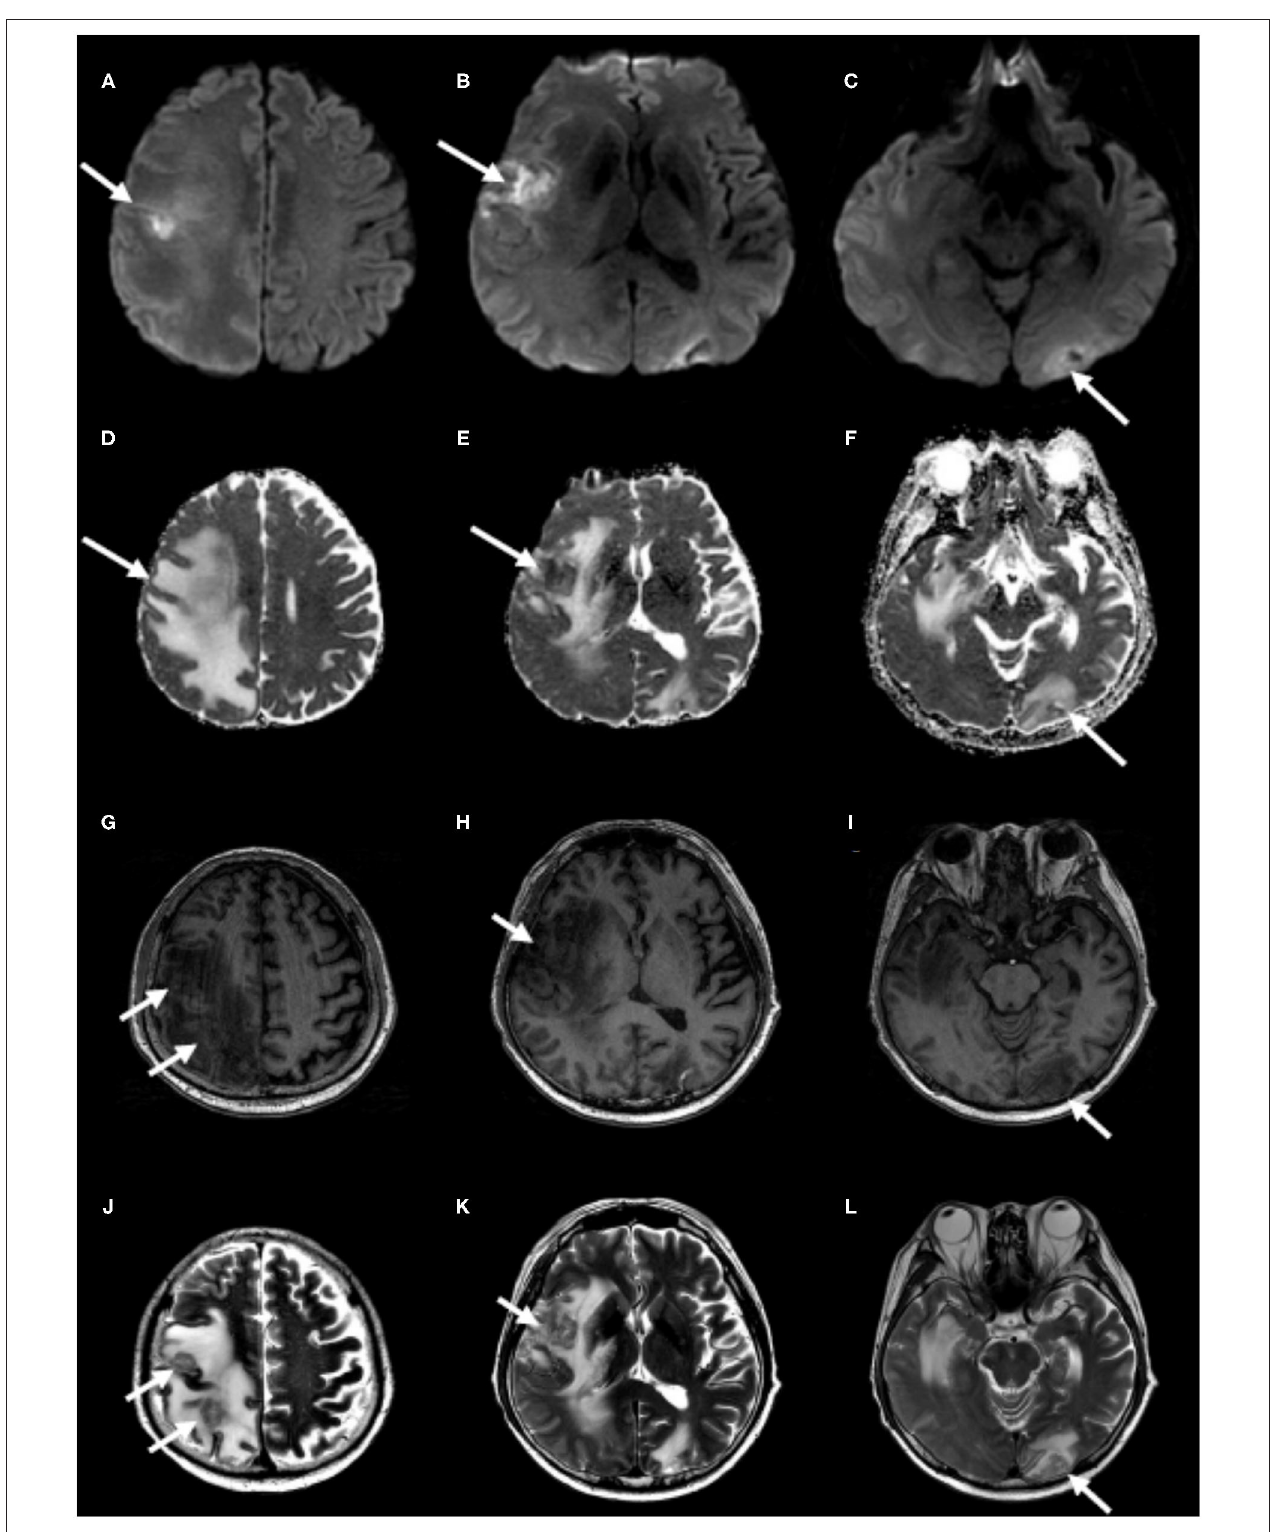
FIGURE 2 | Follow-up brain MRI. Partial diffusion restriction on the right frontotemporal and the left occipital cortices (A–C) without decline of apparent diffusion coefficient values on the corresponding lesions (D–F) and hypointensities on T1-weighted images (G–I) and hyperintensities on T2-weighted images (J–L) , correlating with previously infarcted tissue (white arrows) with perilesional edema, which represents brain metastasis.